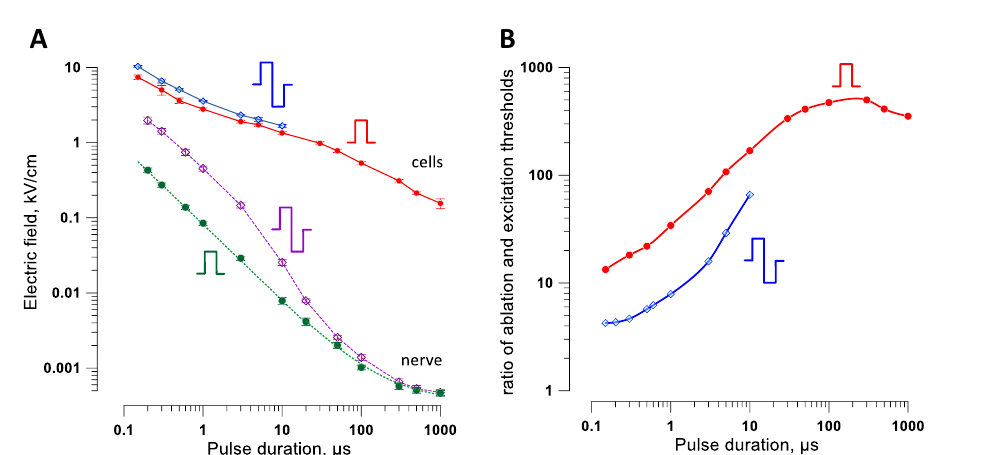
Figure 9. A comparison of the electric field thresholds for cell killing and for peripheral nerve stimulation. ( A ) Strength-duration curves for cell killing (solid lines) and for nerve excitation (dashed lines). Cell killing data are for trains of 300 uni- or bipolar pulses at 10 Hz (same data as in Figs. 6 and 7). Nerve stimulation data are for a single uni- or bipolar pulse as measured in isolated sciatic nerves in a conductive medium (from Fig. 2C in Ref. 43 ). Error bars may be smaller than the central symbol. ( B ) Ratios of the cell killing and nerve stimulation thresholds plotted against pulse duration (for bipolar pulses, against one phase